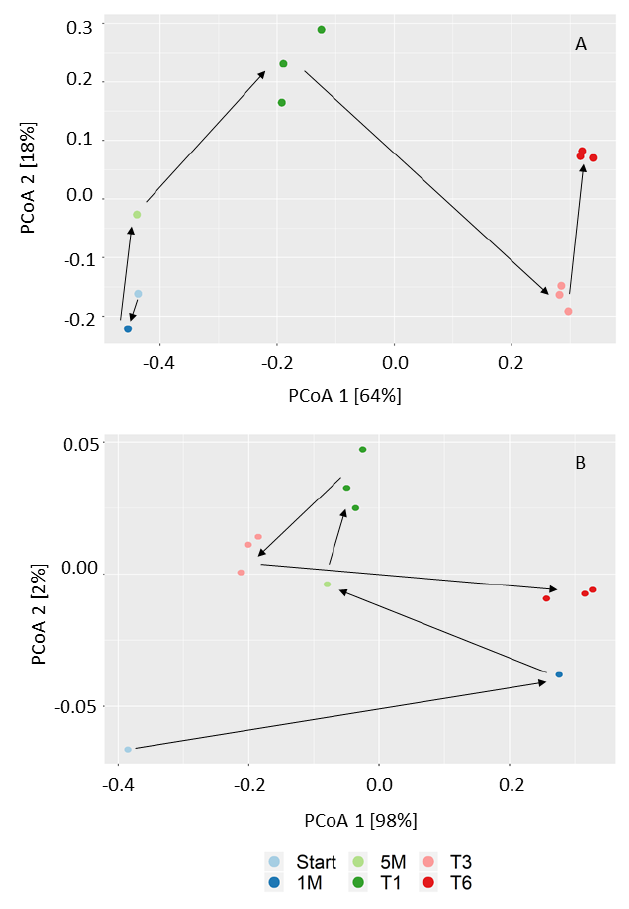
Figure 1. Principal coordinate analysis (PCoA) based on Bray–Curtis distances showing the microbial community shift during the enrichment. ( A ) Bacterial community (16S rRNA gene amplicon sequences) and ( B ) methanogenic community ( mcrA gene amplicon sequences). The labels of the figure are as follows: inoculum (Start), one month (1 M), 5 months (5 M) after fed-batch feeding during the first stage; first transfer (T1), third transfer (T3), and sixth transfer (T6) after fed-batch feeding in the second stage.